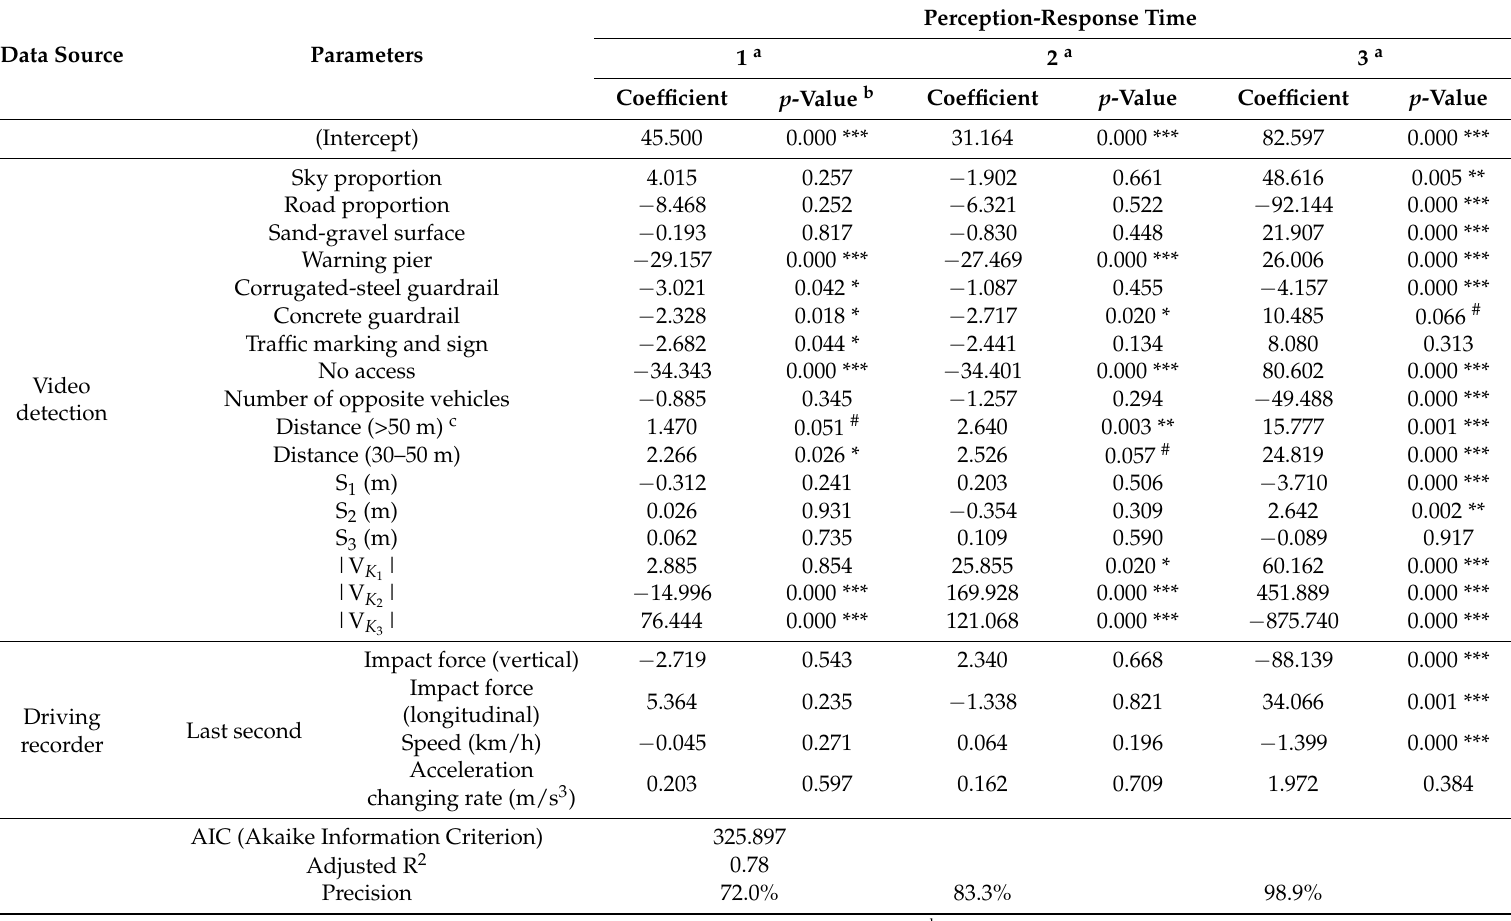
Table 6. Perception-Response Time Prediction Model on Mountain Highway